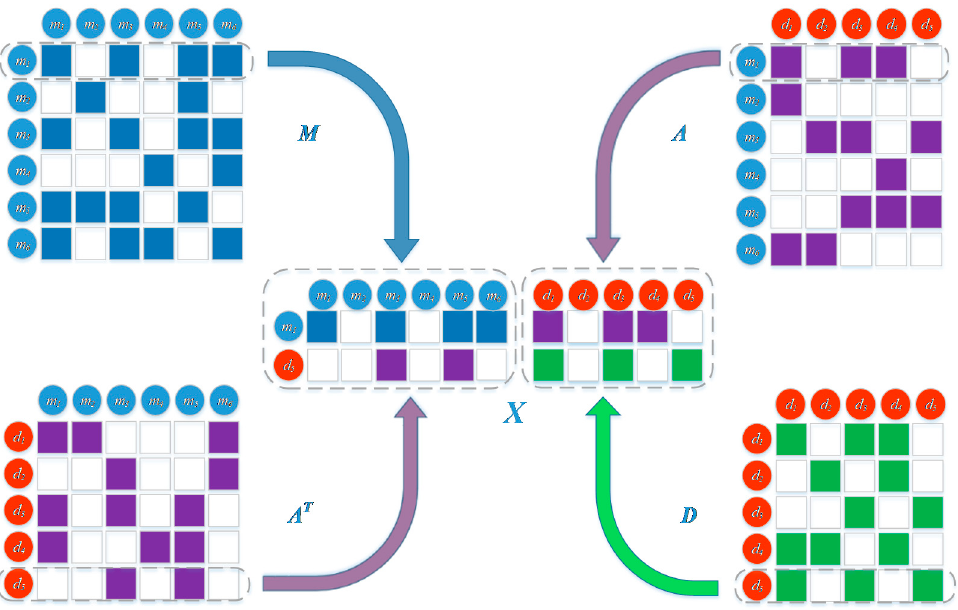
Figure 5. Establishment of the left embedding layer of miRNA m 1 and disease d 5 by combining their similarities and associations.